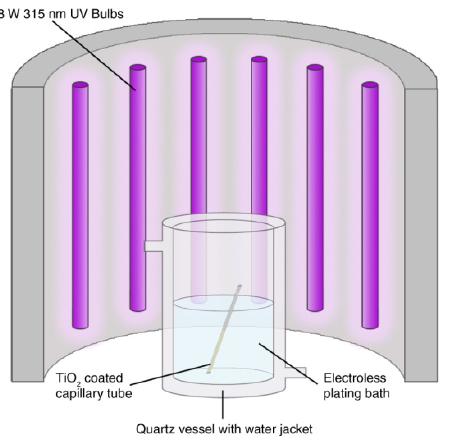
Figure 1. PIED Experimental